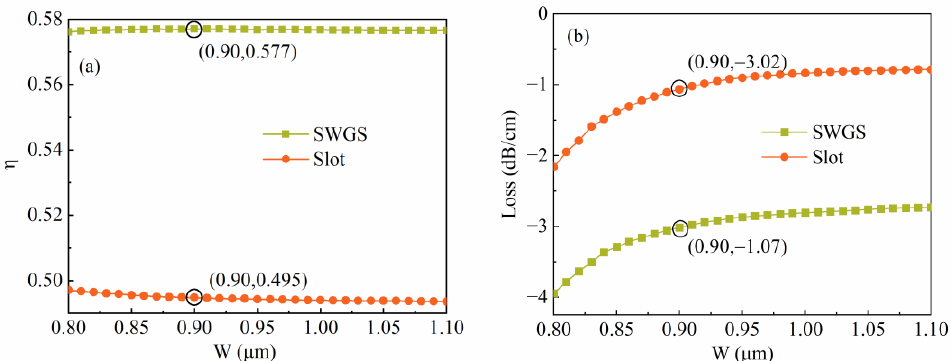
Figure 5. ( a ) Variation of η versus W; ( b ) variation of propagation loss versus W for the SWGS and slot waveguide.